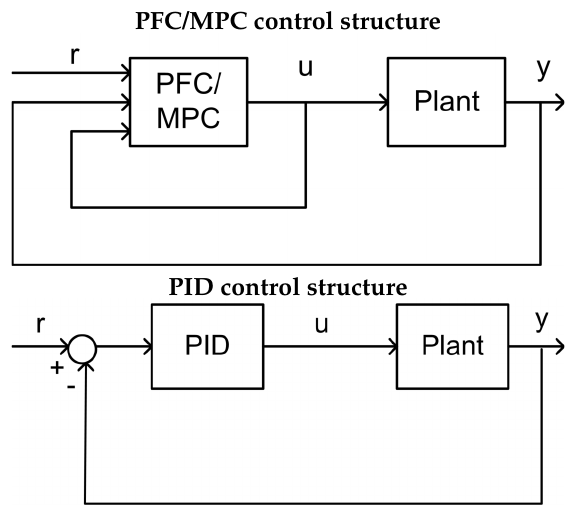
Figure 1. Comparison of flow diagrams for predictive functional control (PFC), model predictive control (MPC), and proportional integral derivative